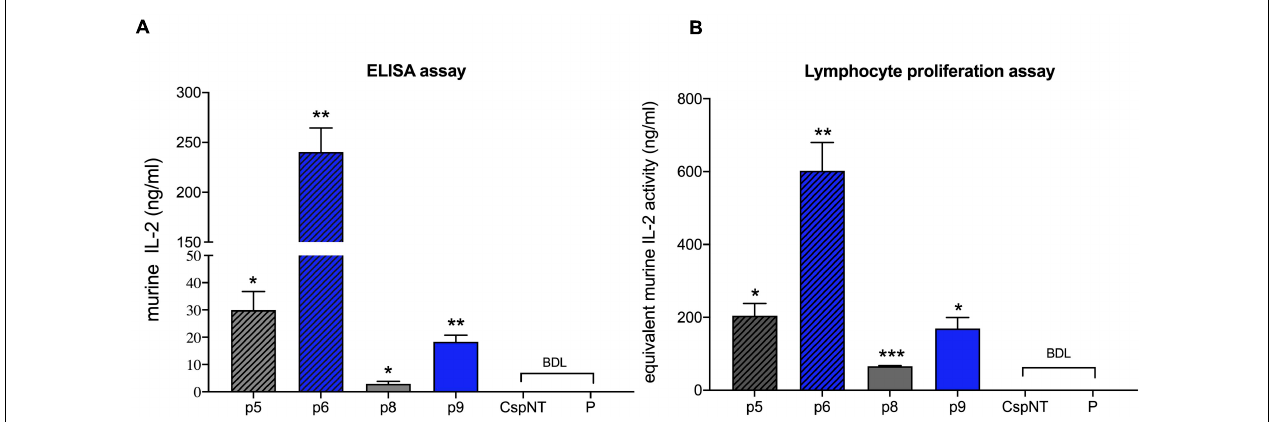
FIGURE 6 | Validation of C. sporogenes -NT variants harbouring plasmid-based mIL-2 in the quantitative and functional assays. (A) Results of commercial ELISA test indicating the quantities of mIL-2 cytokine present in the supernatants of four C. sporogenes -NT-XmIL2F variants following 7-h growth in PYT media. (B) Results of colorimetric MTT functional assay following the incubation of CTLL-2 T-cells in the presence of 7-h culture supernatants of C. sporogenes -NT-XmIL2F variants. Recombinant murine IL2 was used to prepare mIL-2 standard curve. BDL, below detectable levels. Plasmid-based mIL-2 strains were denoted p5, p6, p8, and p9 ( Supplementary Table 1 ), “CspNT” denotes C. sporogenes -NT control, “P” denotes C. sporogenes -NT-pATB1C (empty